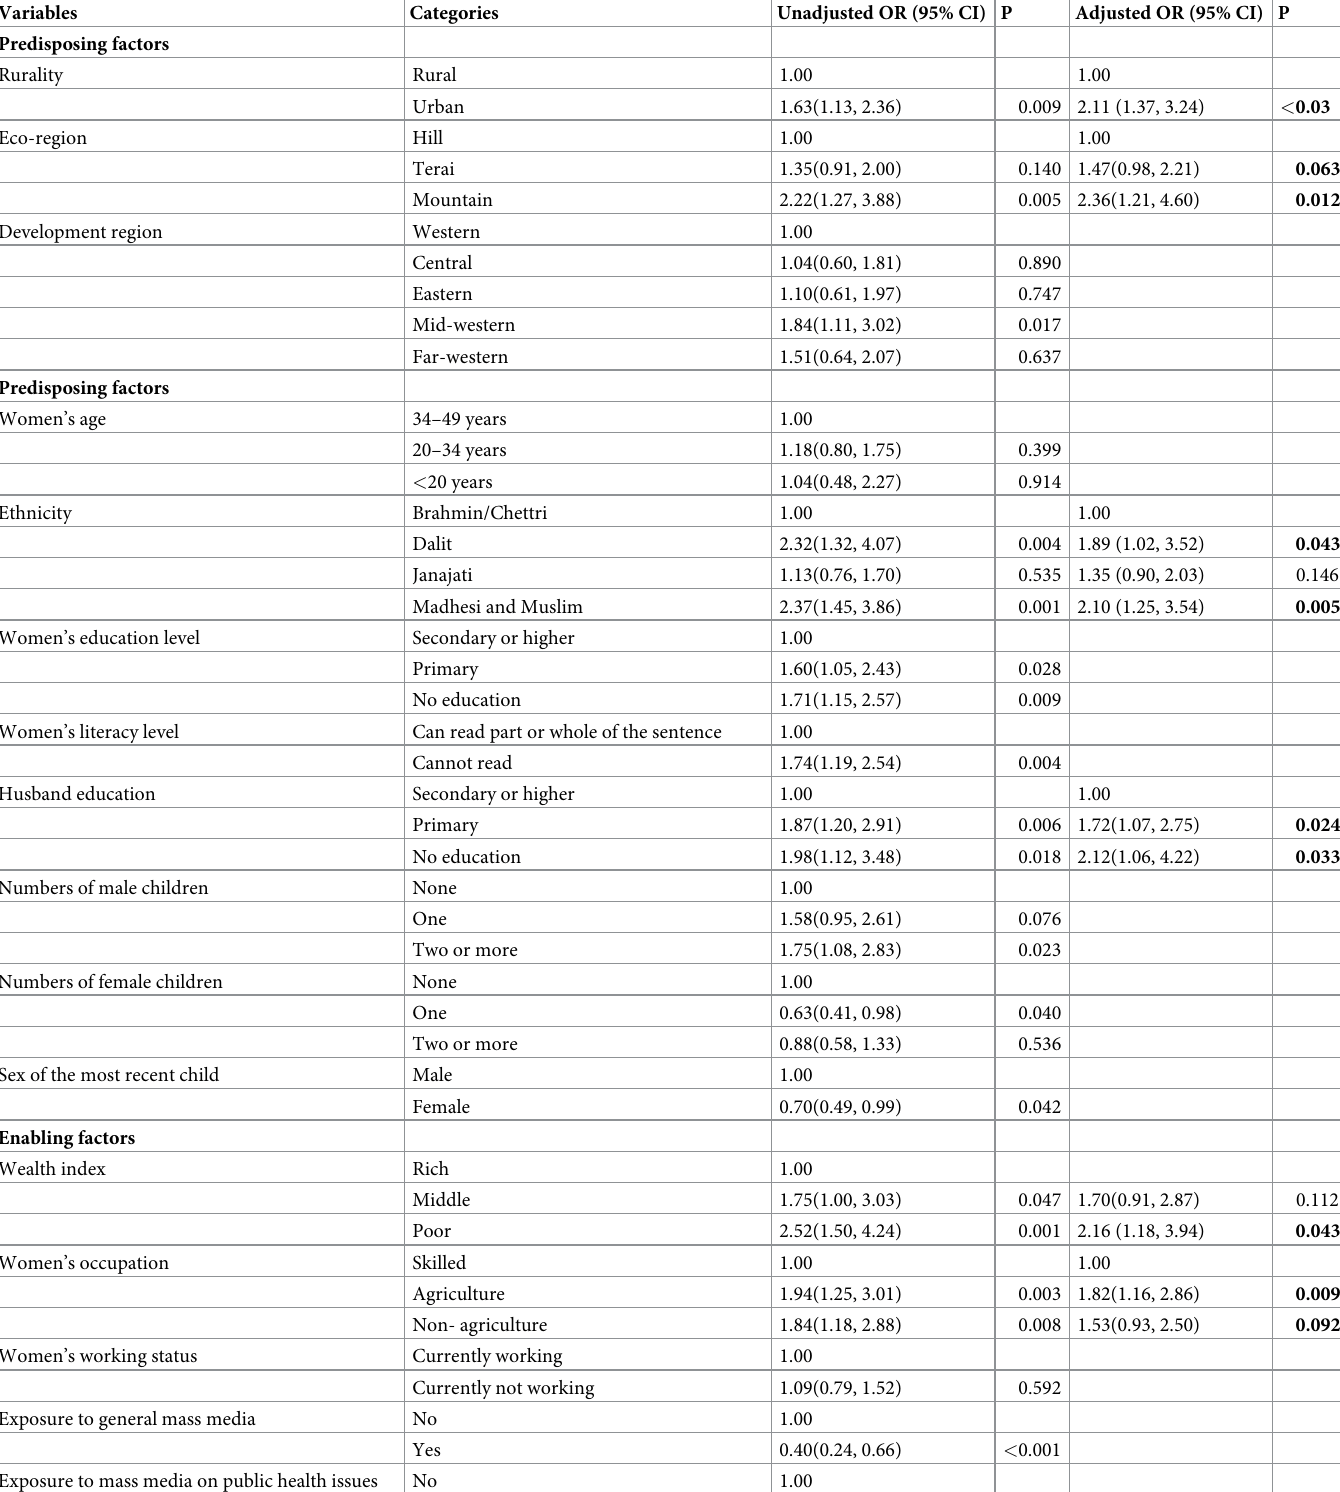
Table 2. Unadjusted and adjusted odds ratio of factors associated with unsafe abortion in Nepal in 2011–2016 (N =